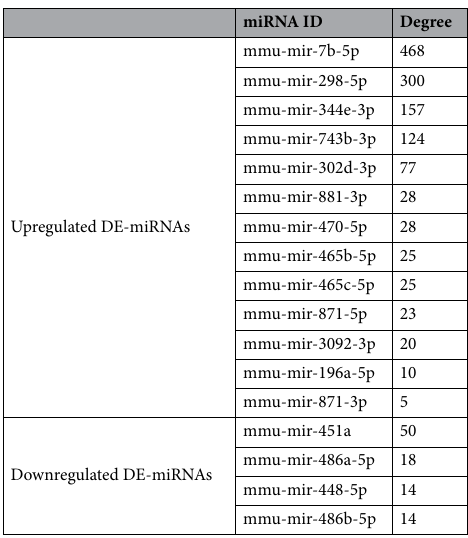
Table 1. Degrees of the target genes of the DE-miRNAs.